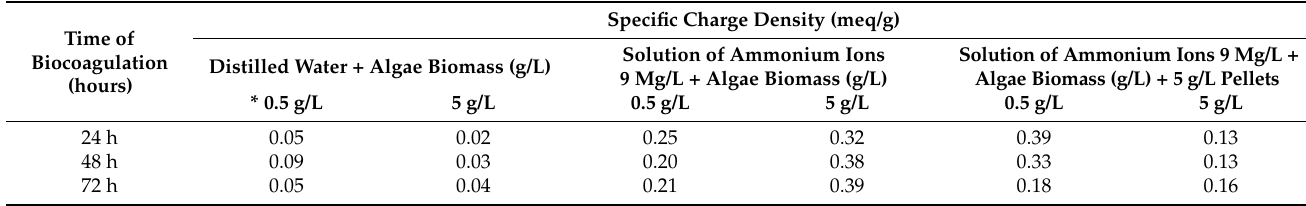
Table 2. Measurement results of the charge of